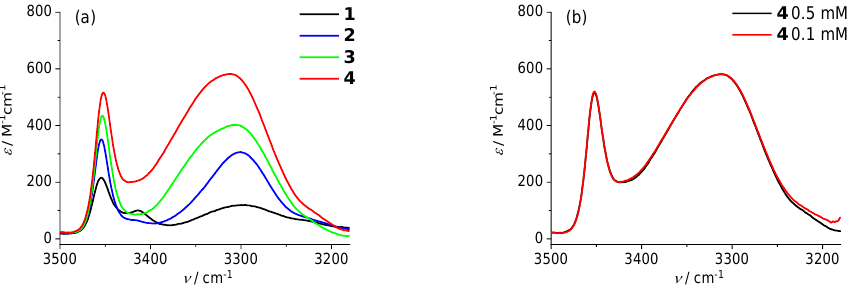
Figure 5. IR absorption spectra in the amide A region of ( a ) 1 – 4 in CDCl 3 solution at 0.5 mM con- centration and ( b ) 4 at 0.5 and 0.1 mM concentration. concentration and ( b ) 4 at 0.5 and 0.1 mM